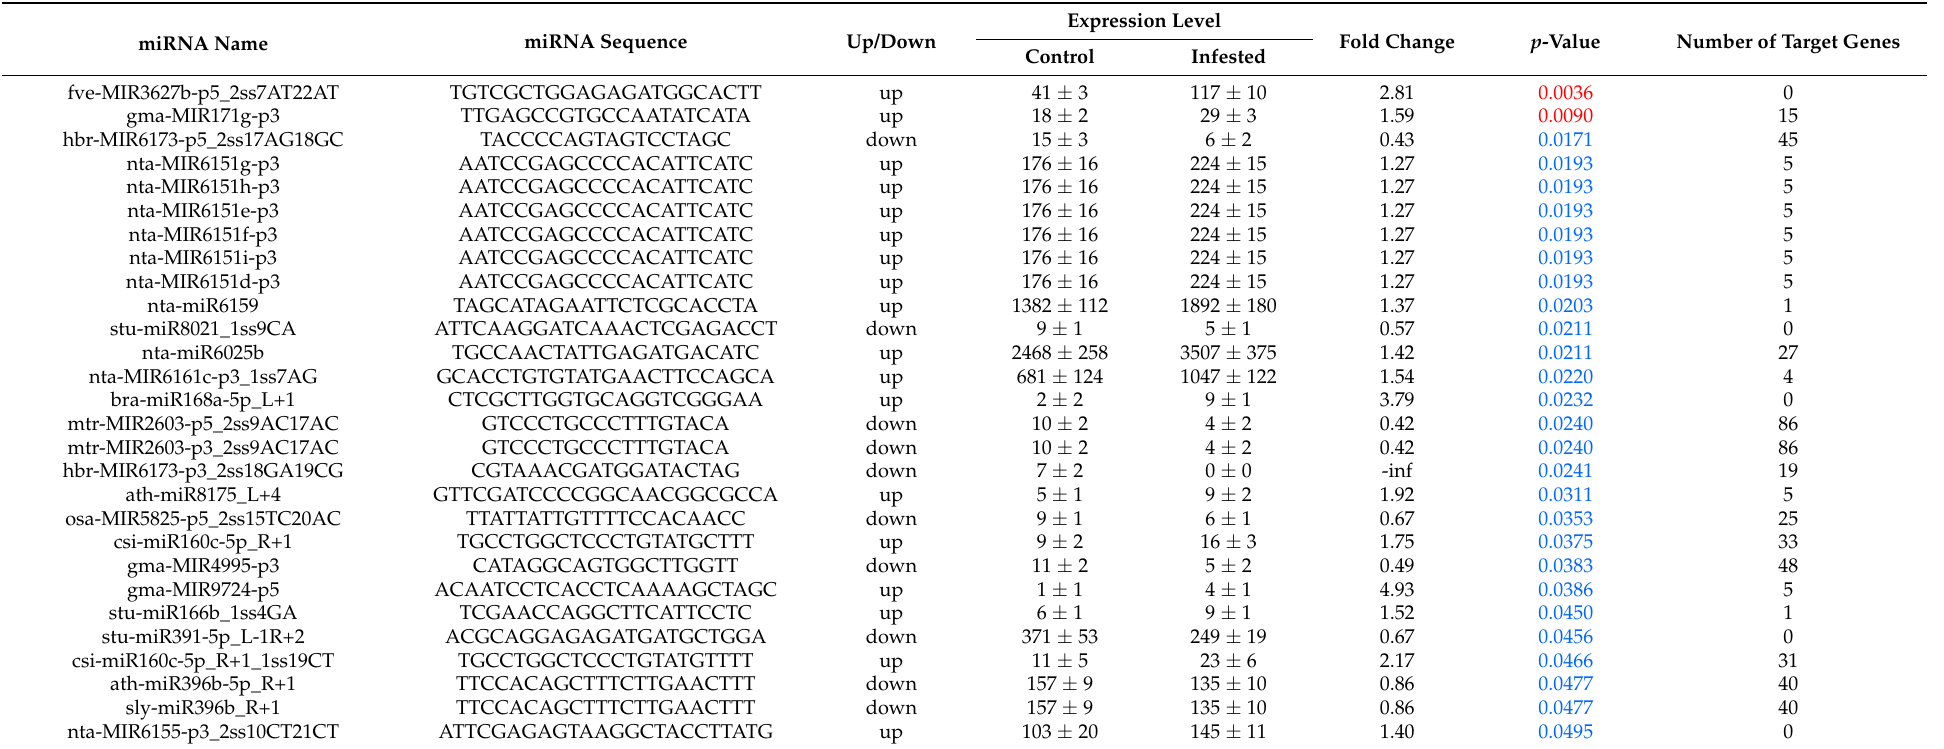
Table 2. Summary table of differentially expressed known miRNAs. The normalized miRNA expression of Control and Infested (mean ± SD). Fold change was obtained by dividing the mean of the expression of the Infested group by the mean of Control. Inf (short for infinity) means the miRNA was only detected in Infested, and -inf means the miRNA was only detected in Control. Statistical significance was evaluated using Student’s t test; p -values colored red were evaluated at p < 0.01, and blue at p <